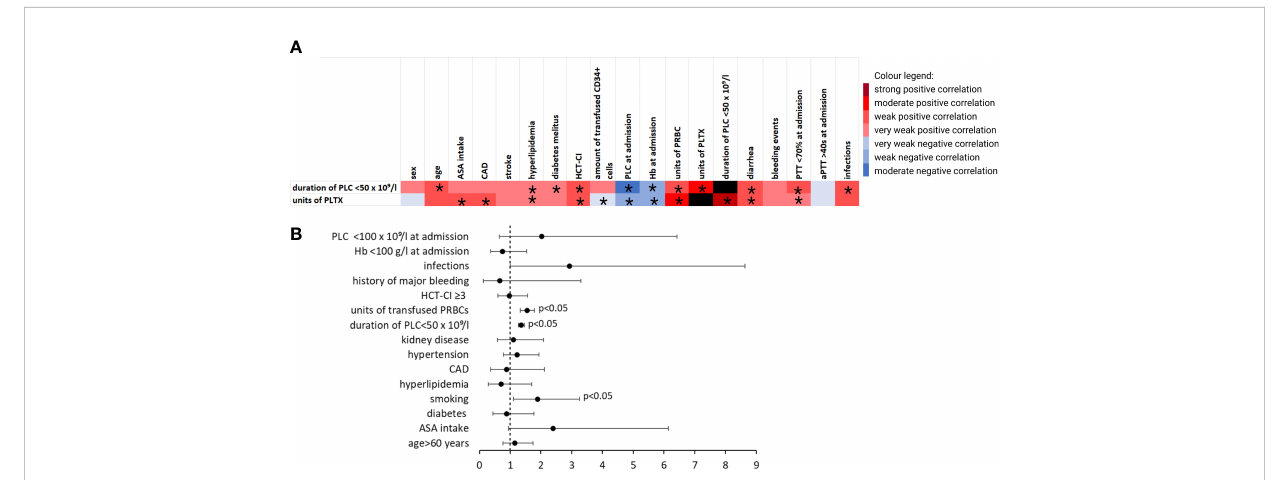
FIGURE 3 Transfusion requirements and duration of thrombocytopenia. (A) Heatmap showing Pearson ’ s correlation coef fi cient (phi coef fi cient for binary variables, respectively) visualizing factors that correlate with requirement of PLTX and duration of PLC < 50 × 10 9 /L. *indicates p < 0.05. (B) ORs for the requirement of >1 unit of platelets in patients without a bleeding event from multivariate logistic regression analysis after using stepwise estimation by backward and forward selection. aPTT, activated partial thromboplastin time; ASA, acetylsalicylic acid; CAD, coronary artery disease; Hb, hemoglobin; HCT-CI, hematopoietic stem-cell transplantation comorbidity index; PLC, platelet count; PLTX, platelet transfusion; PRBC, packed red blood cells (in units); PTT, prothrombin time. .